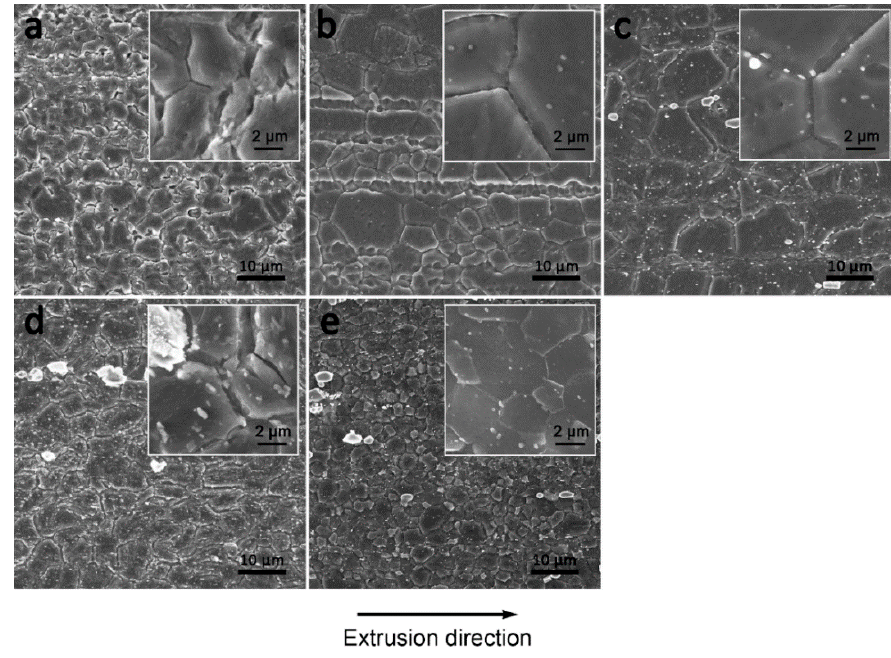
Figure 8. The SEM micrographs of as-extruded Mg–4Sm– x Zn–0.5Zr alloys observed on the longitudinal section along the extrusion direction: ( a ) x = 0; ( b ) x = 1; ( c ) x = 2; ( d ) x = 3; ( e ) x = 4.